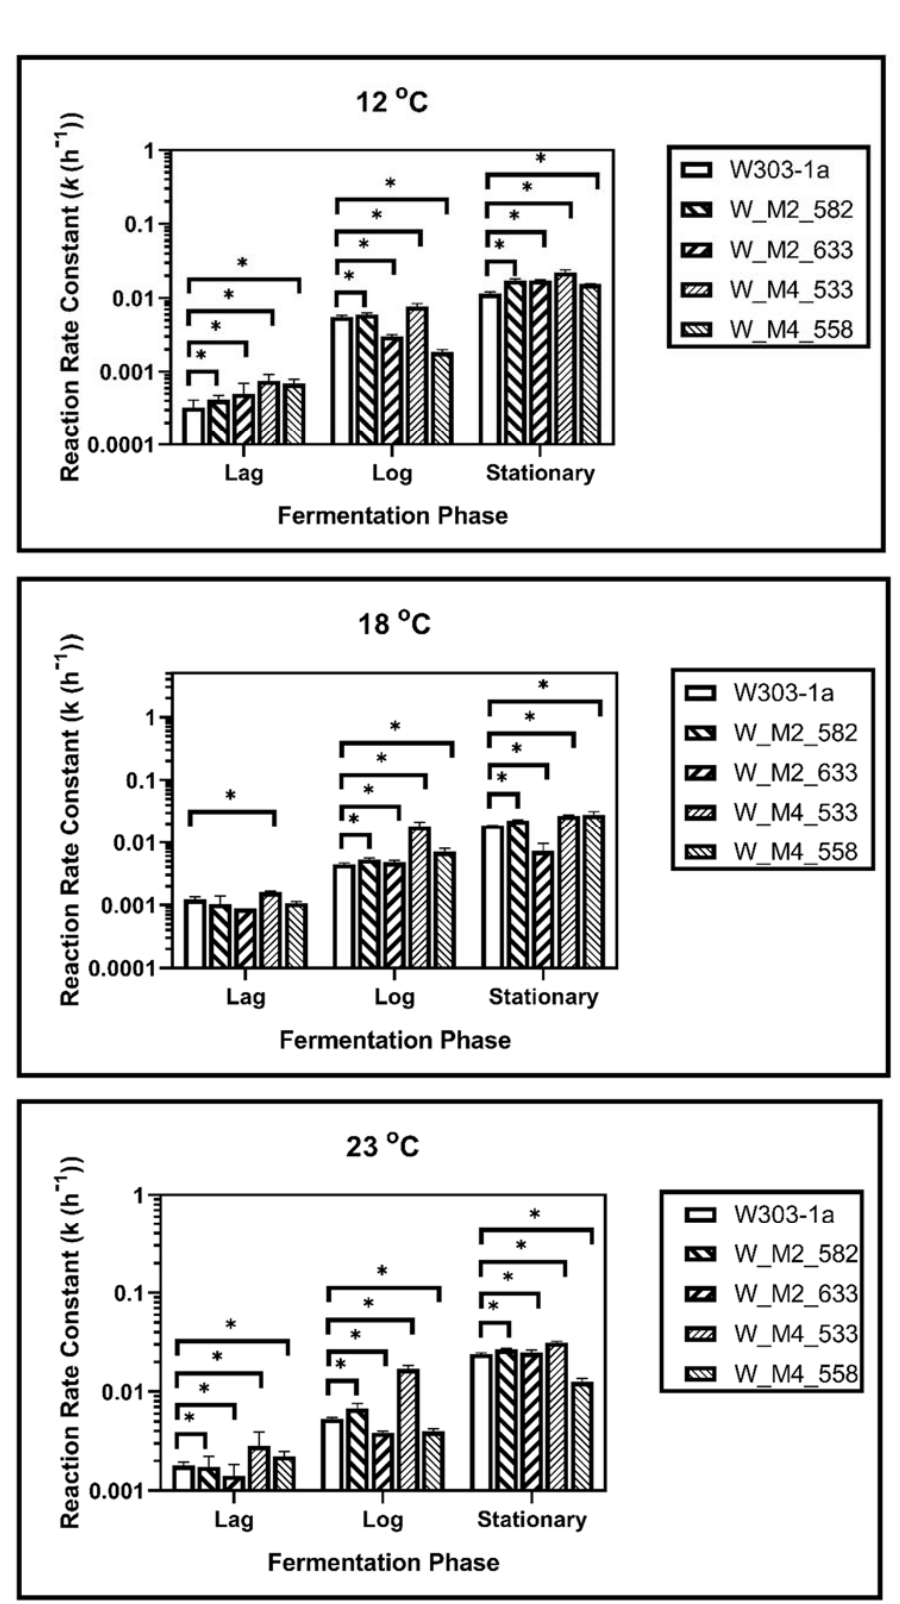
Figure 7. Reaction rate constants of hexose catabolism during alcoholic fermentation regarding phases for each strain at 12, 18 and 23 °C. The statistically significant differences are nominated by asterisks: (*: p < 0.05).